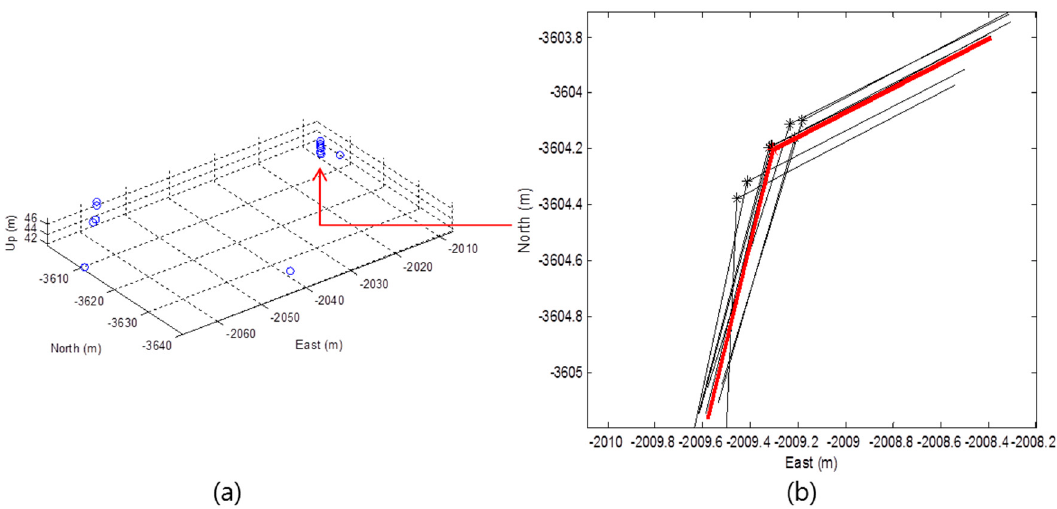
Figure 8. ( a ) 3D position of corner candidates; ( b ) Corner determination result.